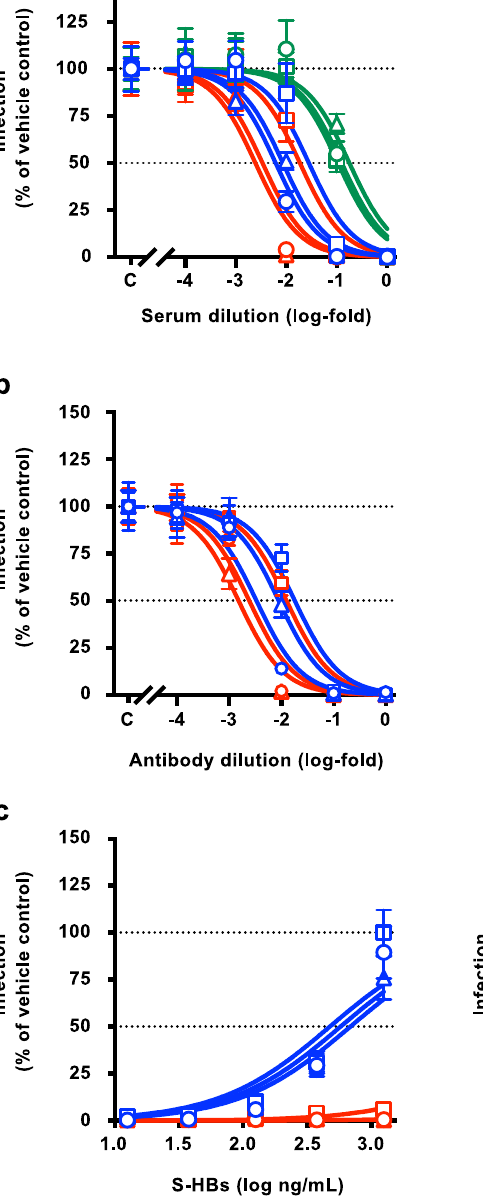
assessed by measuring the NL activities of infected cells in 5 wells at 7 days after infection and indicated the mean±SD at each dilution. The dose – response curves with the log (inhibitor) vs. normalized response model were drawn, and the IC 50 valueswerecalculated.Themean±SEofIC 50 valuesofthreeanimalsisindicatedin the right panel. c The speci fi cities of induced antibodies to the neutralizing effects were assessed using an antibody adsorption assay with S-HBs or L-HBs antigens. Thepuri fi edantibodiesinducedinS-HBsvaccine-(blue)andL-HBs+Addavax-(red) immunized macaques were prepared at the 10-fold concentration of IC 50 values and mixed with S-HBs or L-HBs antigens at the indicated concentrations. HBV/NL- WT was incubated with antigen-adsorbed antibodies and used to infectG2/NT18-C cells. The infection ef fi ciencies at the indicated concentrations of S-HBS or L-HBs antigens wereassessed by measuring the NL activities of infectedcells in 5 wellsat 7 days after infection and indicated the mean±SD at each concentration. The dose – response curveswiththelog(inhibitor)vs.normalizedresponsemodelwere drawn. Source data are provided as a Source Data fi